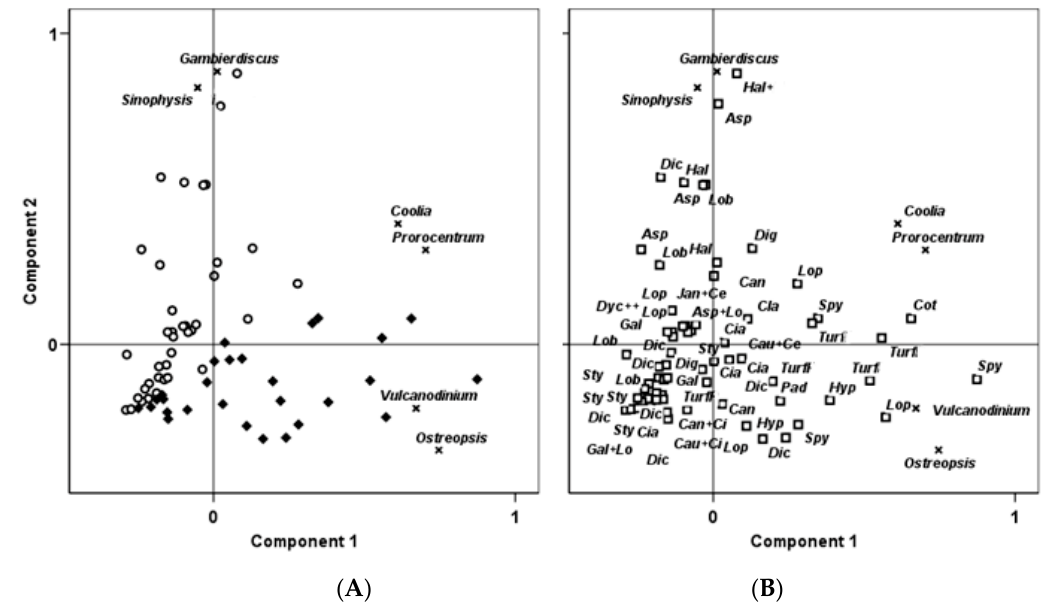
Figure 2. Plot of the scores derived from PCA of the concentrations of epibenthic dinoflagellate genera from the two stations, Cotillo (circles) and Playitas (diamonds) ( A ); and the macrophytes corresponding to each sample ( B ) (see macrophyte codes in Table 1). Crosses represent the factor loadings of the different dinoflagellate genera.